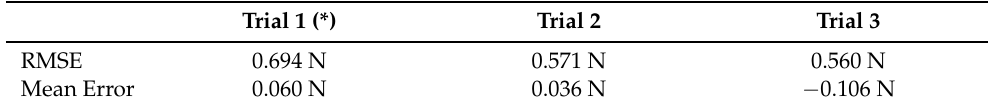
Table 3. RMSE and Mean Prediction Error During Palpation Using a Direct Force Feedback Method- ology. Asterisk (*) indicates presented experimental results.